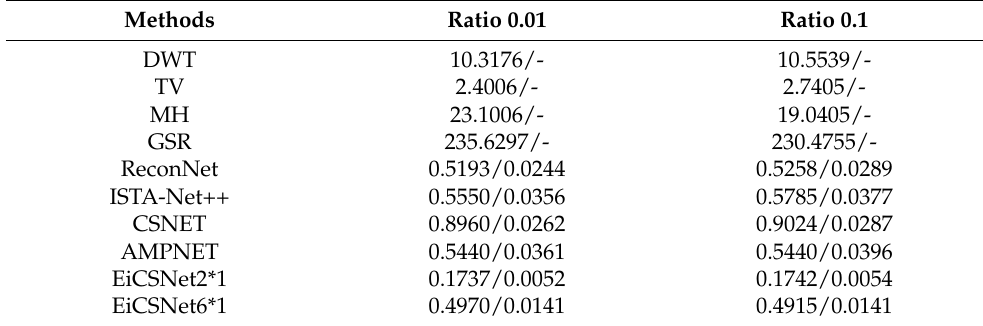
Table 6. The run time of the different